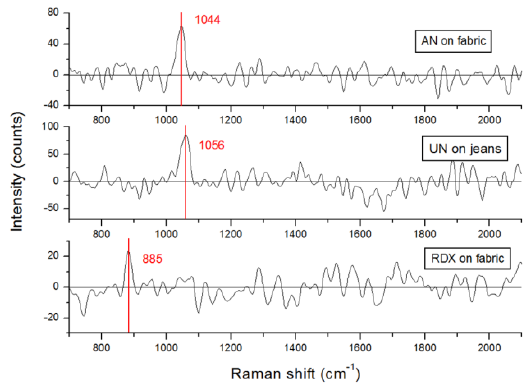
Figure 8. Processed single-shot Raman spectra in the eye-safe regime measured on the first-generation fingerprints of ammonium-nitrate, RDX, or urea-nitrate placed on a dyed tissue at a 10 m distance from the instrument. Red lines indicate the peaks detected automatically by the instrument’s software.